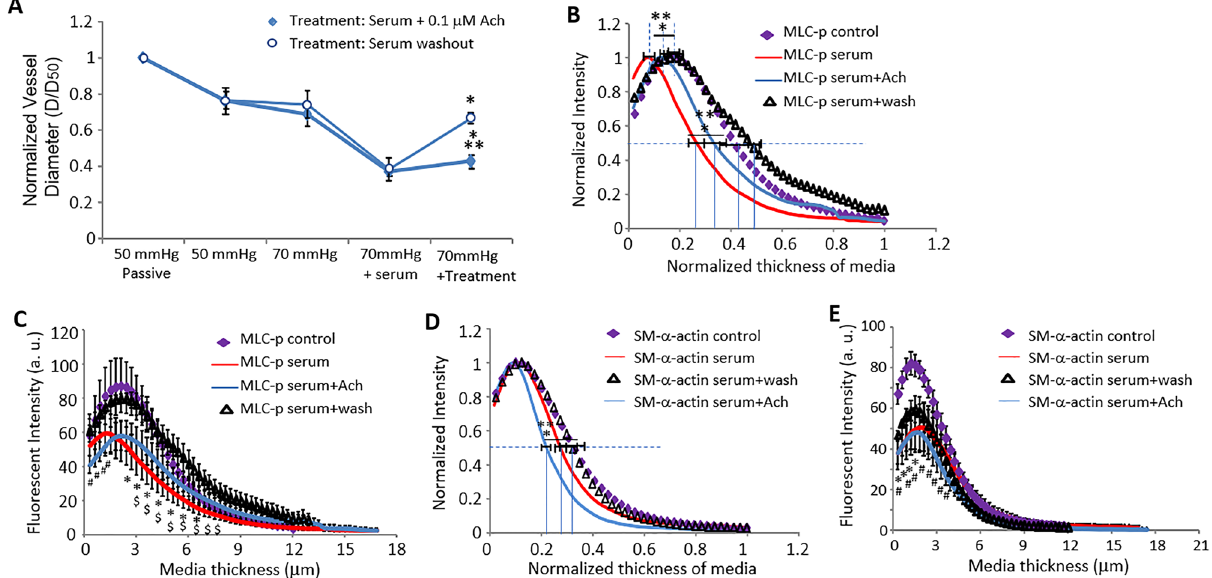
Figure 6. Reversal of serum induced SCA vasoconstriction. ( A ) Serum induced vasoconstriction of SCA was modestly inhibited by Ach (10^-7 M), but was largely reversed following washout of the added serum. D: vessel diameter 10 min after pressure elevation or after treatment; D 50 : passive vessel diameter at 50 mmHg. Data are presented as Mean ± SEM. *: p < 0.05 compared to vessel diameter at 70 mmHg + 10% serum, ** p < 0.05 compared to 70 mmHg intraluminal pressure alone; n = 7 vessels for Ach treated group, and n = 5 for serum + wash group. ( B ) Normalized transmural distribution profile of MLC-p in contracted SCAs at 70 mmHg pressure under basal conditions, in the presence of 10% serum, serum + 0.1 μM ACh or following serum washout. The MLC-p profile shifted back to the distribution observed under control conditions after serum washout; while treatment with Ach induced no significant shift of MLC-p profile compared with treatment by serum alone. Data are presented as Mean ± SEM. * p < 0.05 compared to control; ** p < 0.05 compared to serum washout. ( C ) The absolute intensity of MLC-p fluorescence across the arterial wall decreased in the presence of either 10% serum alone or serum + 0.1 μM ACh, and recovered to control levels following treatment washout. Data are displayed as Mean ± SEM. n = 6 vessels for control and serum-treated group respectively; n = 7 for serum + Ach and n = 4 for serum washout group. # p < 0.05, serum + Ach vs. control group; * p < 0.05, serum vs. control group; $ p < 0.05, serum vs. serum washout group. ( D ) Normalized transmural distribution of SM-α-actin in SCAs at 70 mmHg pressure under basal conditions, and in the presence of 10% serum alone or serum + 0.1 μM ACh. Addition of Ach led to a further shift of the SM-α-actin profile to the left compared with serum constricted vessels. Serum washout reversed these observed shifts in SM-α-actin distribution to the control profile. * p < 0.05, serum + Ach vs. control; ** p < 0.05 serum + Ach vs. serum washout. ( E ) The addition of either 10% serum alone or serum + 0.1 μM ACh decreased the intensity profile of SM-α-actin fluorescence across the arterial wall, which remained altered following treatment washout. Data are displayed as Mean ± SEM. * p < 0.05, serum vs. control group; # p < 0.05, serum + Ach vs. control group. n = 5 vessels for control, serum, serum washout and serum + Ach group